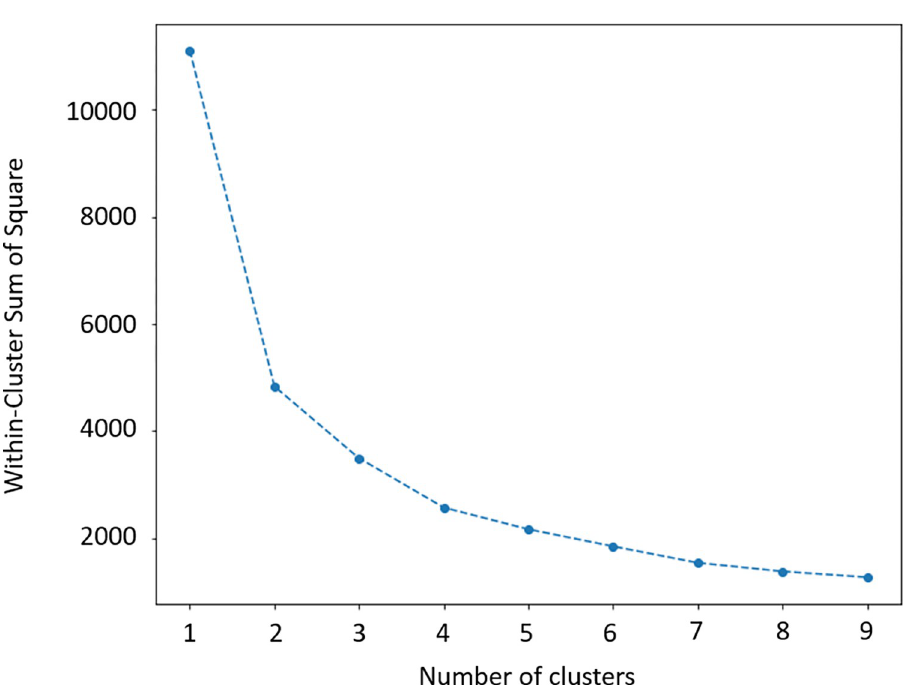
Fig 6. Performance according to each number of clusters using unsupervised learning with k-means and PCA. Clustering without considering null attempts nor considering the number of attempts.